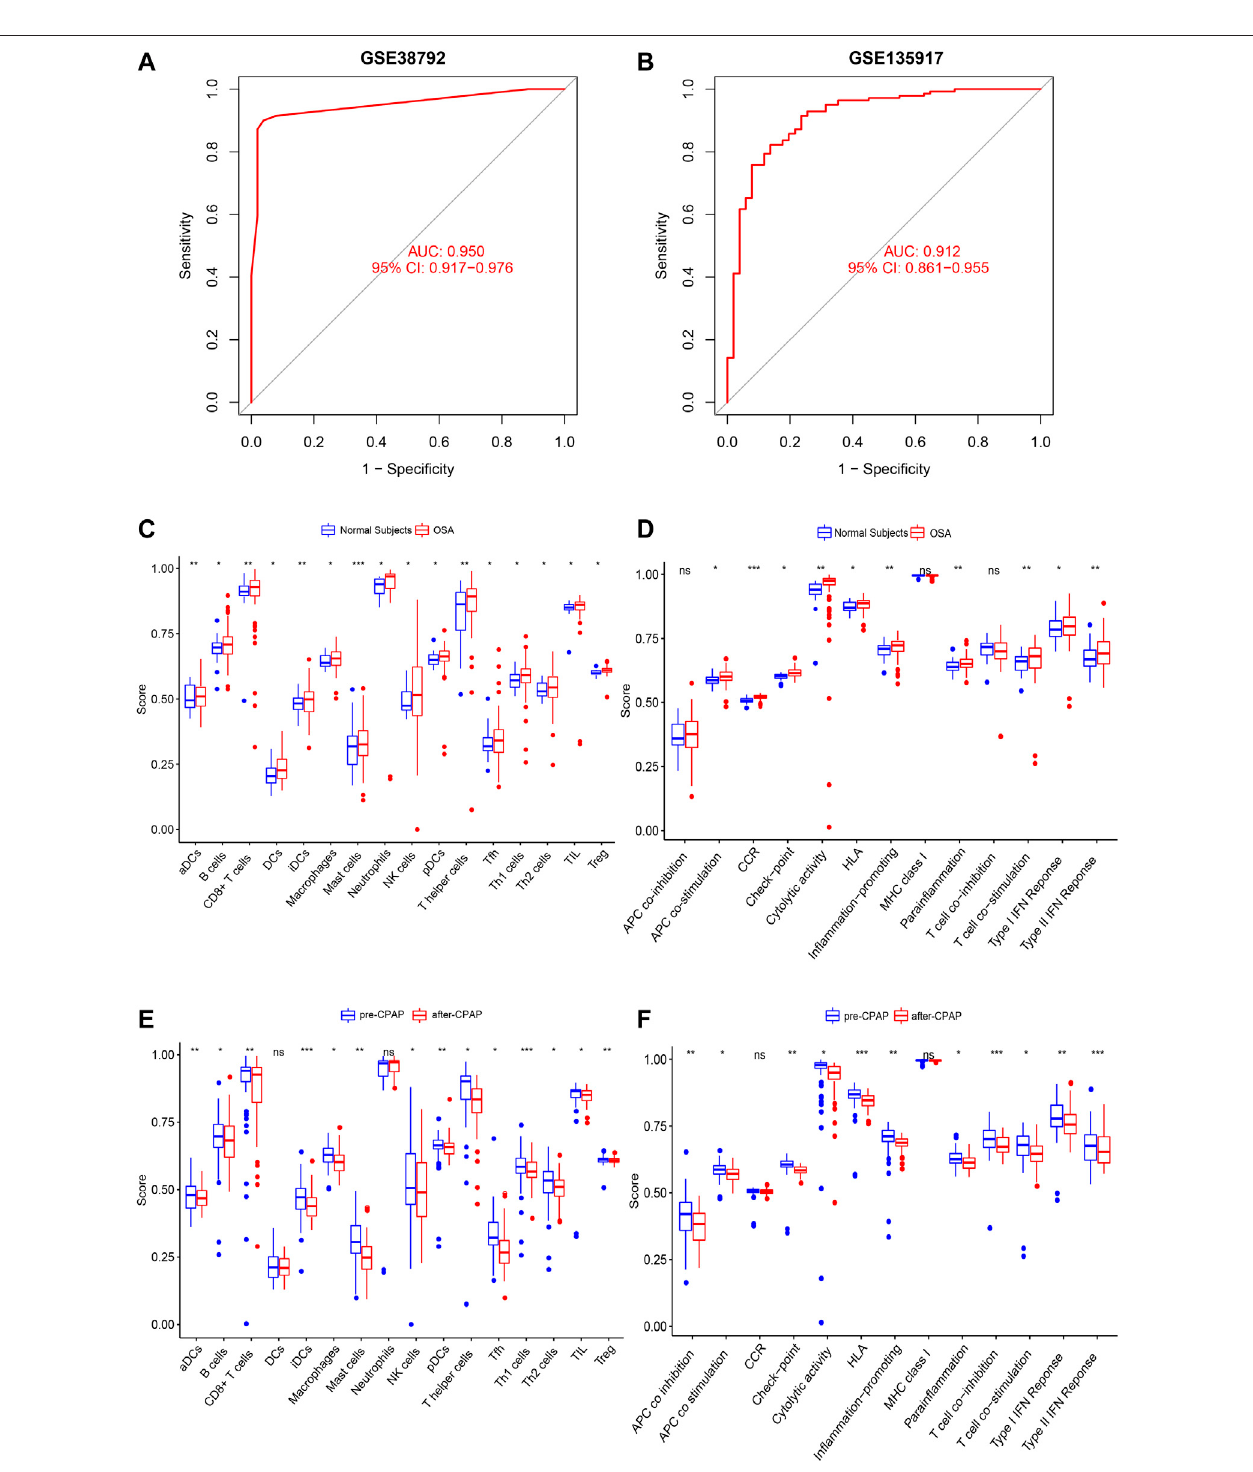
FIGURE 7 | (A,B) Veri fi cation of the ROC curves by the ANN model for the GSE38792 and GSE135917 datasets. (C,D) The enrichment levels of 28 immune- related cells and functions in the ssGSEA results for the OSA cohort. Besides APC co-inhibition, MHC Class I, and T cell co-inhibition, other cell components, and functional pathways showed higher ssGSEA scores in OSA patients. (E,F) The enrichment levels of 28 immune-related cells and functions in the ssGSEA results for the CPAP cohort. Aside from DCs, Neutrophils, CCRs, and MHC class I, other immune cells and functions showed a downward trend in ssGSEA scores after CPAP treatment. *, p < 0.05; **, p < 0.01; ***, p < 0.001.